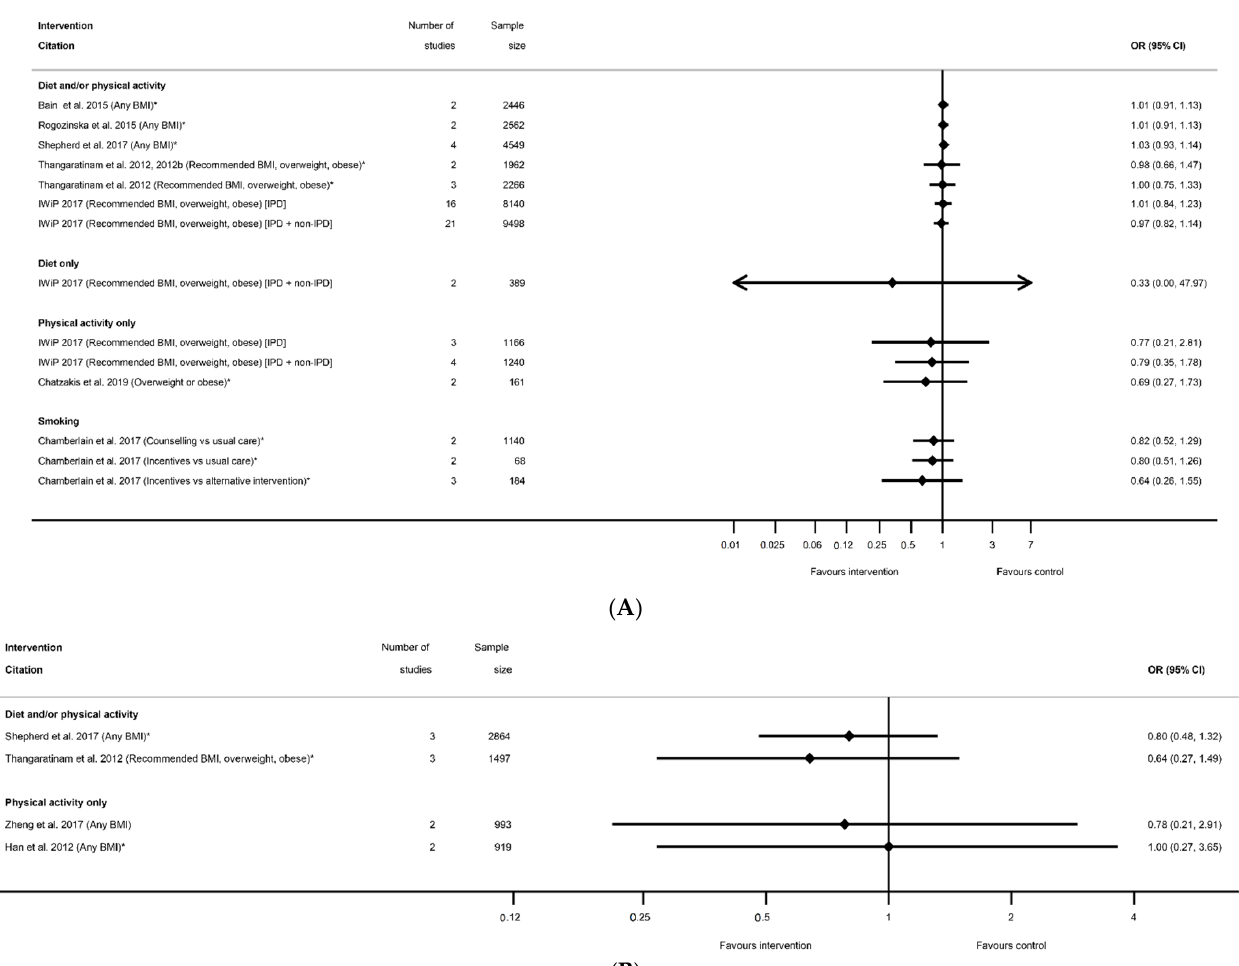
Figure 15. Forest plot of meta-analysis results for ( A ) Neonatal Intensive Care Unit (NICU) admission and ( B ) low Apgar score. * indicates the estimate is relative risk.